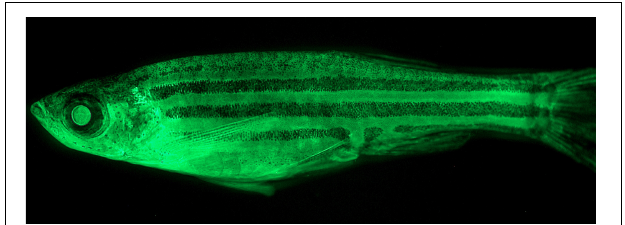
FIGURE 1 | Gh -transgenic zebrafish ( Danio rerio ). The F0104 line was developed from the co-injection of two separate transgenes, both containing the carp β -actin promoter ( Cyprinus carpio ), which controls the expression of the GFP gene from the jellyfish Aequorea victoria or the GH gene from the marine silverside fish ( Odonthestes argentinensis ). Linearized transgenes were co-injected in an equimolar ratio into zebrafish zygotes to provide the same genome integration and expression (Figueiredo et al., 2007). In the F0104 line, GFP expression works not only as a marker of transgenesis but also allows mapping the tissues that are expressing GH since both GFP and GH are under the control of the same gene promoter.